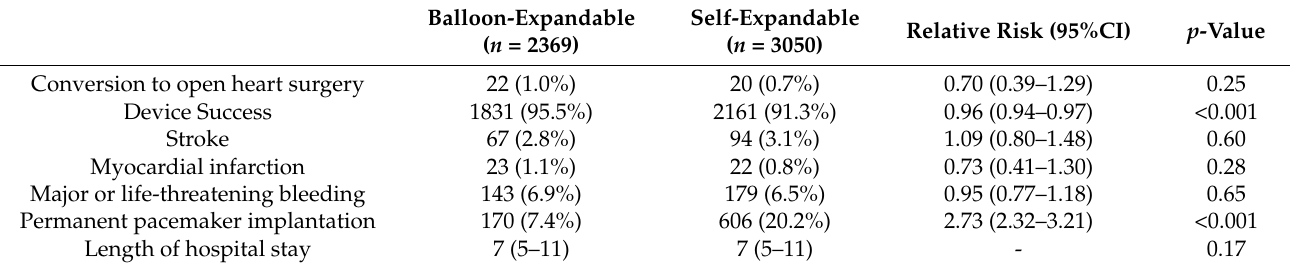
Table 3. Procedural and in-hospital outcomes for patients treated with BE- vs.